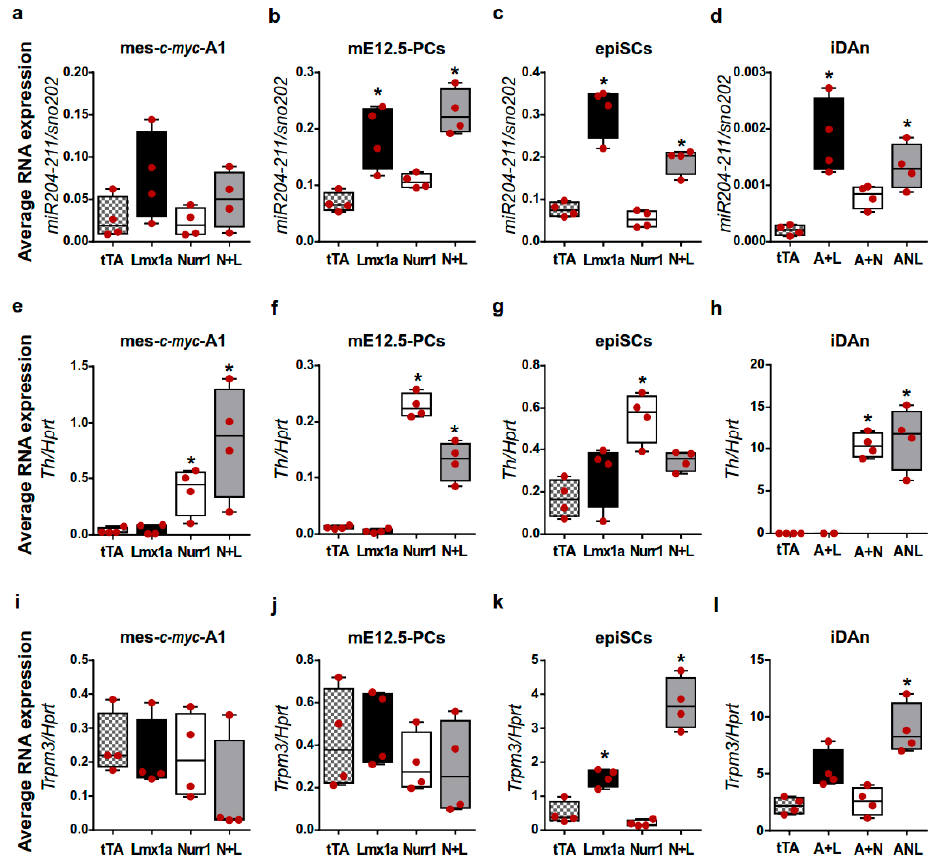
Figure 3. Lmx1a overexpression promotes miR-204/211 expression in vitro. ( a – l ) TaqMan assay and qPCR for miR-204/211 ( a – d ), Th ( e – h ), and Trpm3 ( i – l ) on differentiated mes-c-myc-A1 ( a , e , i ), mE12.5-PCs ( b , f , j ), epiSCs ( c , g , k ), induced dopaminergic neurons (iDAn; ( d , h , l )) differentiated into mDAn. miR-204/211 values are normalized on the reference sno-202, while Th and Trpm3 levels are normalized on the reference mRNA Hprt. Data represent the median, the 25th to 75th percentiles, the minimum, and the maximum of 2 −Δ Ct values from four independent biological replicates. L = Lmx1a, N Nurr1, A = Ascl1. * p < 0.05 with respect to controls infected with the only transactivator vector rtTA (one-way ANOVA + Tukey post hoc test).